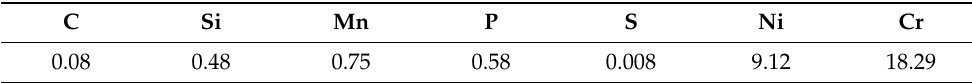
Table 1. Chemical composition of SUS304 stainless steel (unit: %).